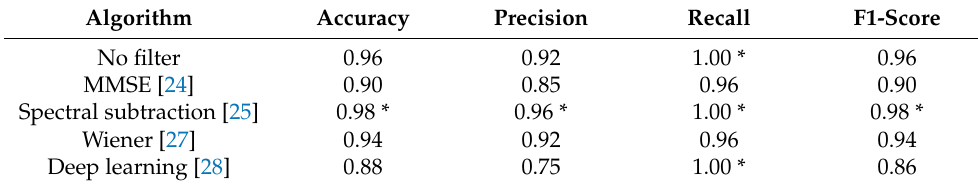
Table 4. Babble Noise SNR 5. * is the best result for each particular measure.